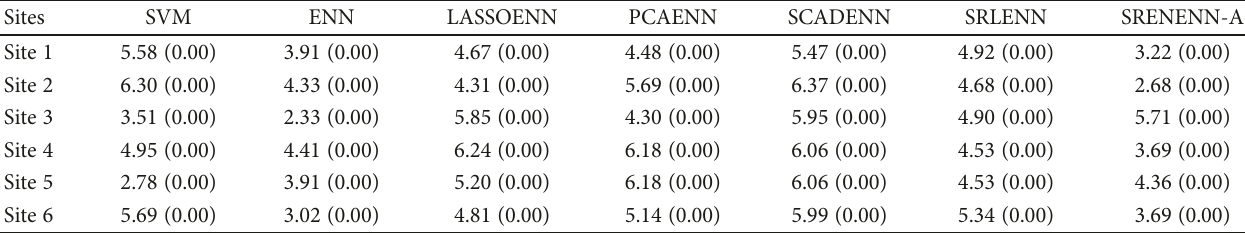
Table 7: The results of Wilcoxon signed-rank tests between SRENENN-B and other competitors ( p values are in the parenthesis). Sites